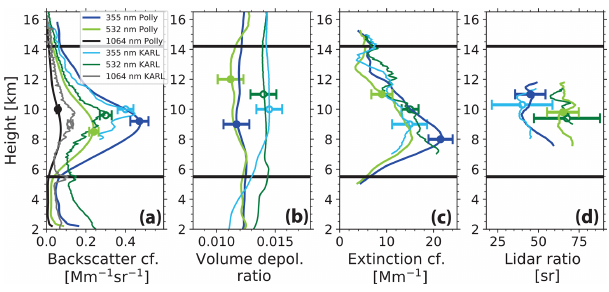
Figure 12. Same as in Fig. 11 except for 7 November 2019 (20:25– 23:35UTC; 85.9 ◦ N, 116.8 ◦ E). KARL (AWI lidar at Ny-Ålesund, Svalbard, Norway; 78.9 ◦ N, 11.9 ◦ E) observations from 4 Novem- ber 2019 are shown for comparison (open symbols; thin lines). In the case of the KARL measurements, 2400m vertical signal smoothing is applied. Note that panel (b) shows the volume depo- larization ratio instead of the particle linear depolarization ratio as in Fig. 11. Good agreement between the different observation was found. Tropopause over Polarstern was at 7.6km